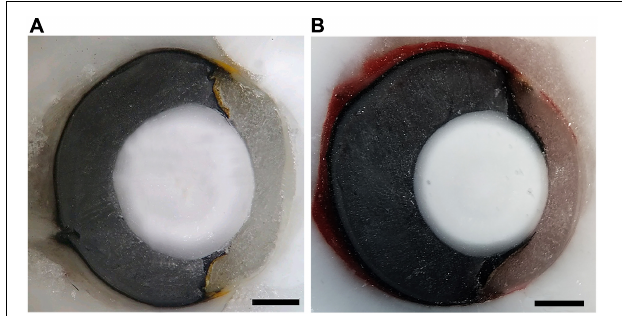
FIGURE 4 | Cryosectioned eye from adults of (A) B. jararaca and (B) C. durissus . Scale bars: 1 mm.